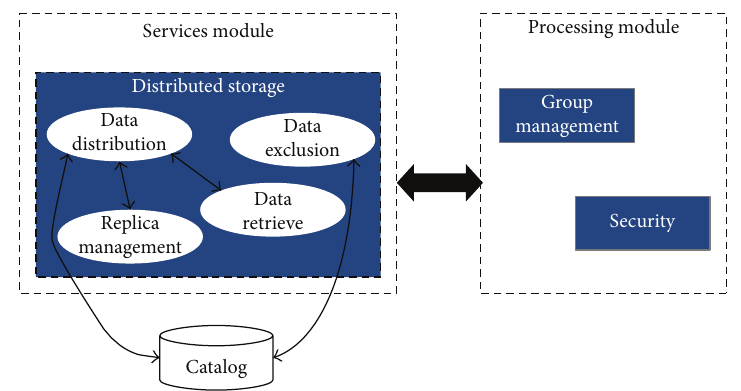
Figure 5: Components of distributed storage component.